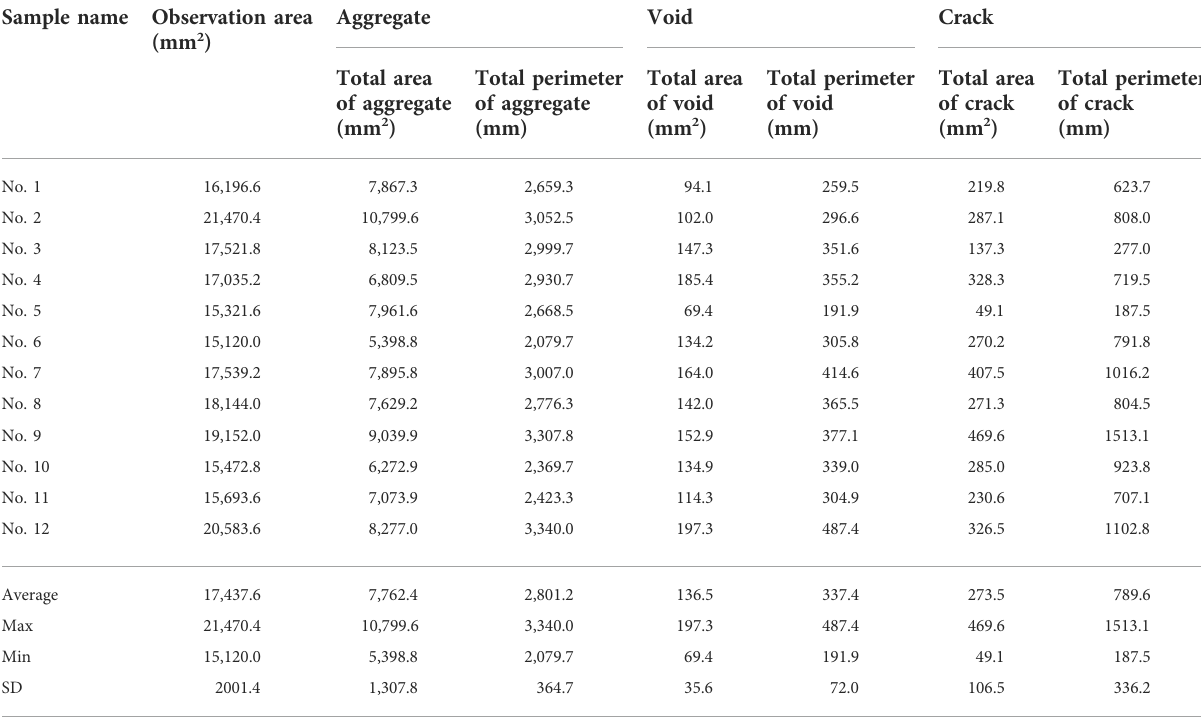
TABLE 4 Geometric properties of concrete